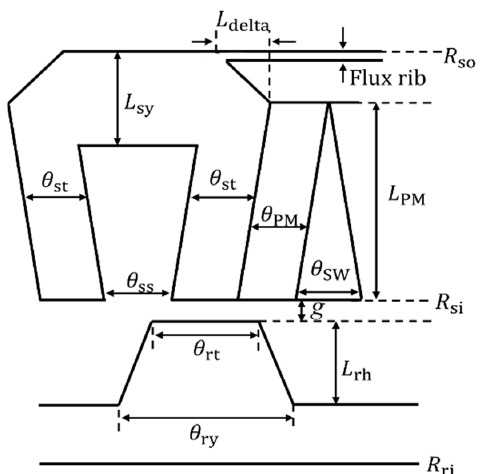
Figure 2. Design variables. Figure 2. Design Table 1. Dimensions of the initial and the optimal V-shaped FSPM generators.